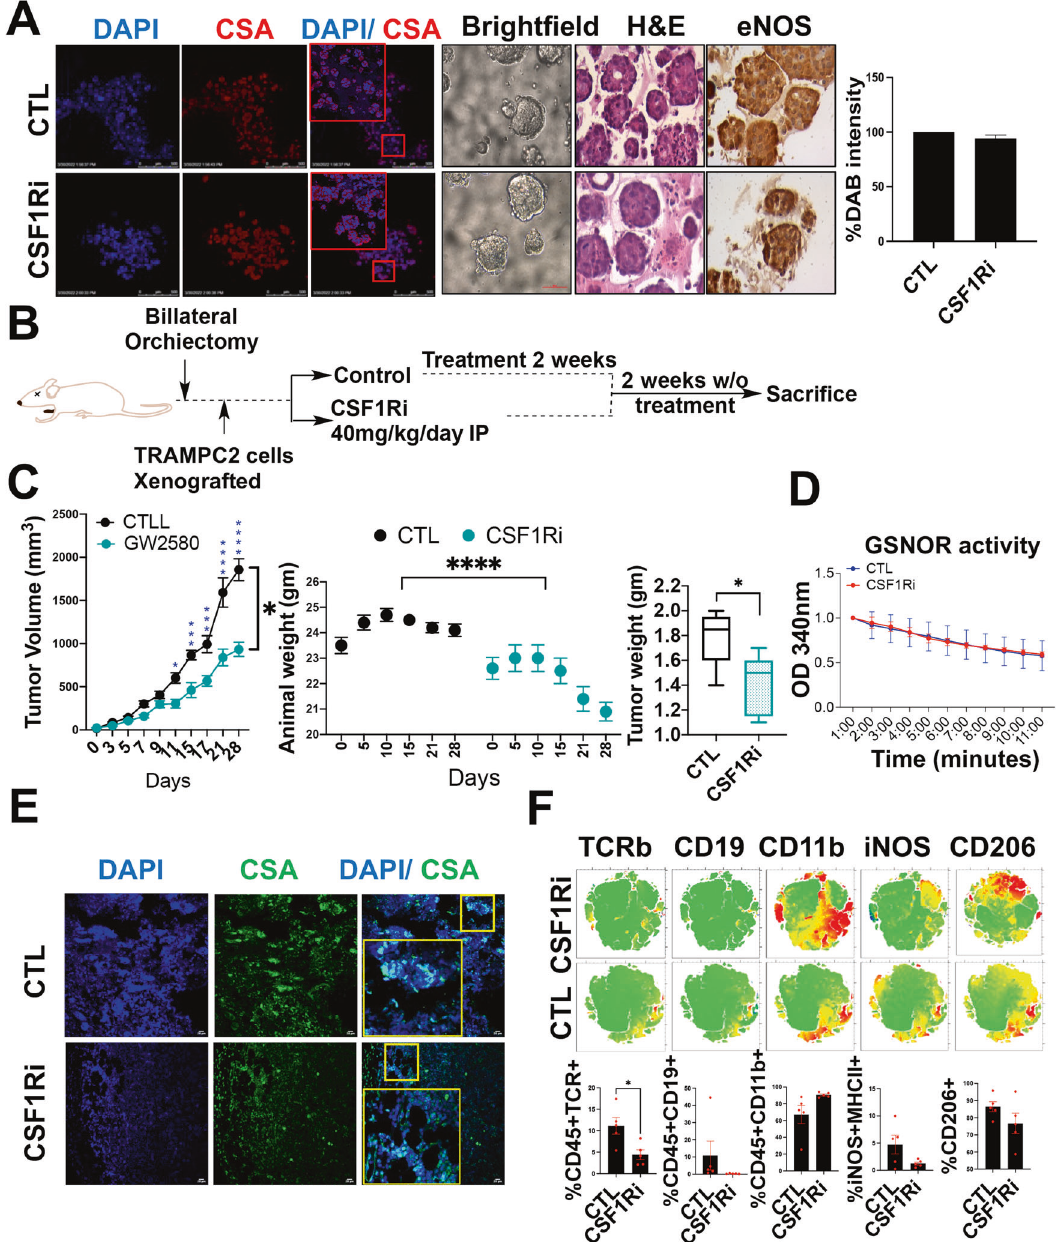
(red) showing oxidation status. The chromogenic substrate DAB (brown) represents the expression of NOS3 in untreated control and CSF1Ri treated organoids. Scale bar 400 μ m. B Experimental plan. C Mean change of tumor volume (±SEM; versus tumor volume at treatment start) in C5BL6 mice treated as indicated. Vehicle ( n = 5), α -CSF1R ( n = 5). Animal weight changes throughout the experiment from Day 1 to Day 28. Tumor weight plotted as Mean ± SEM ( n = 5) measured at the end of the experiment. D GSNOR activity was measured at 340 nm for 10 minutes using tumor lysates treated with vehicle and CSF1R inhibitor ( n = 3). E Representative immuno fl uorescent images for tumor sections for mice treated with vehicle and CSF1R inhibitor and stained with 4 ′ ,6-diamidino-2-phenylindole (DAPI) (blue) and Cysteine sul fi nic acid (red) ( n = 3). F Representative tSNE plots and graphs for various immune cell surface markers (TCR β , CD19, CD11b, iNOS, and CD206) for tumor cells isolated from mice tumors treated with vehicle and CSF1R